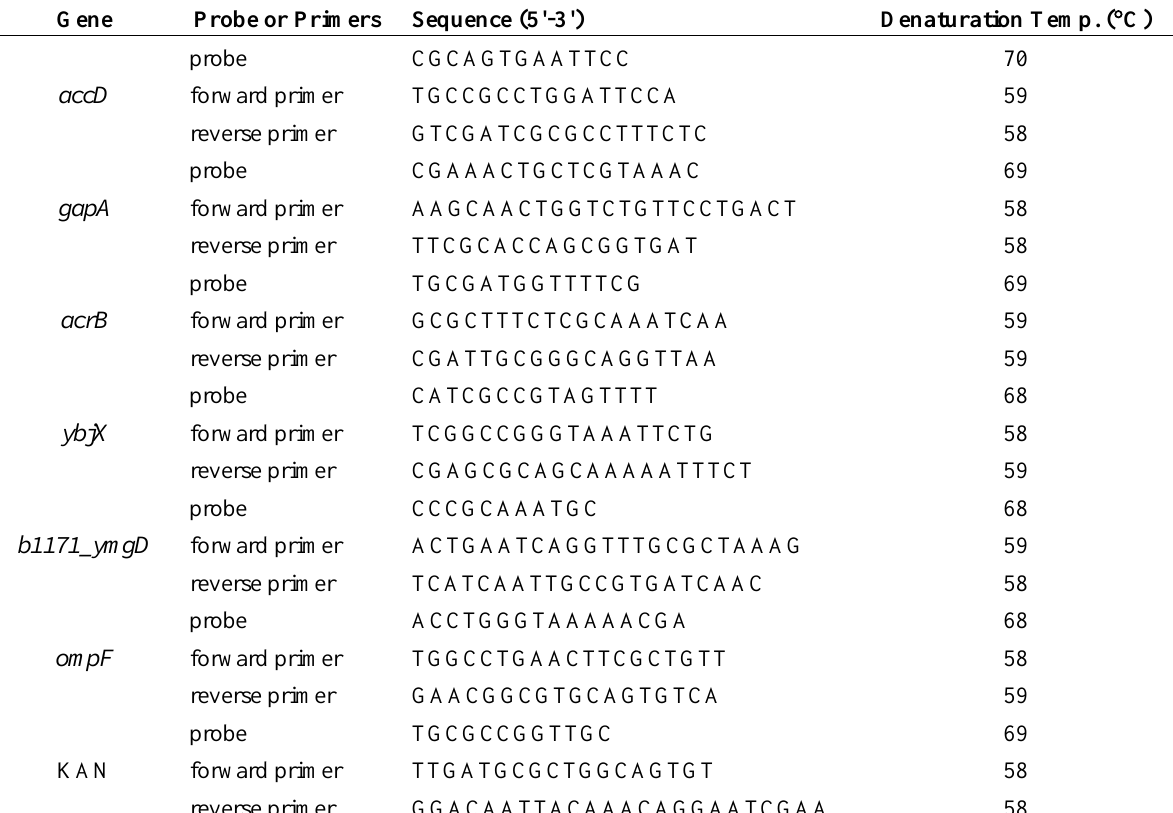
Table 4. Primers and fluorogenic probes for real-time PCR